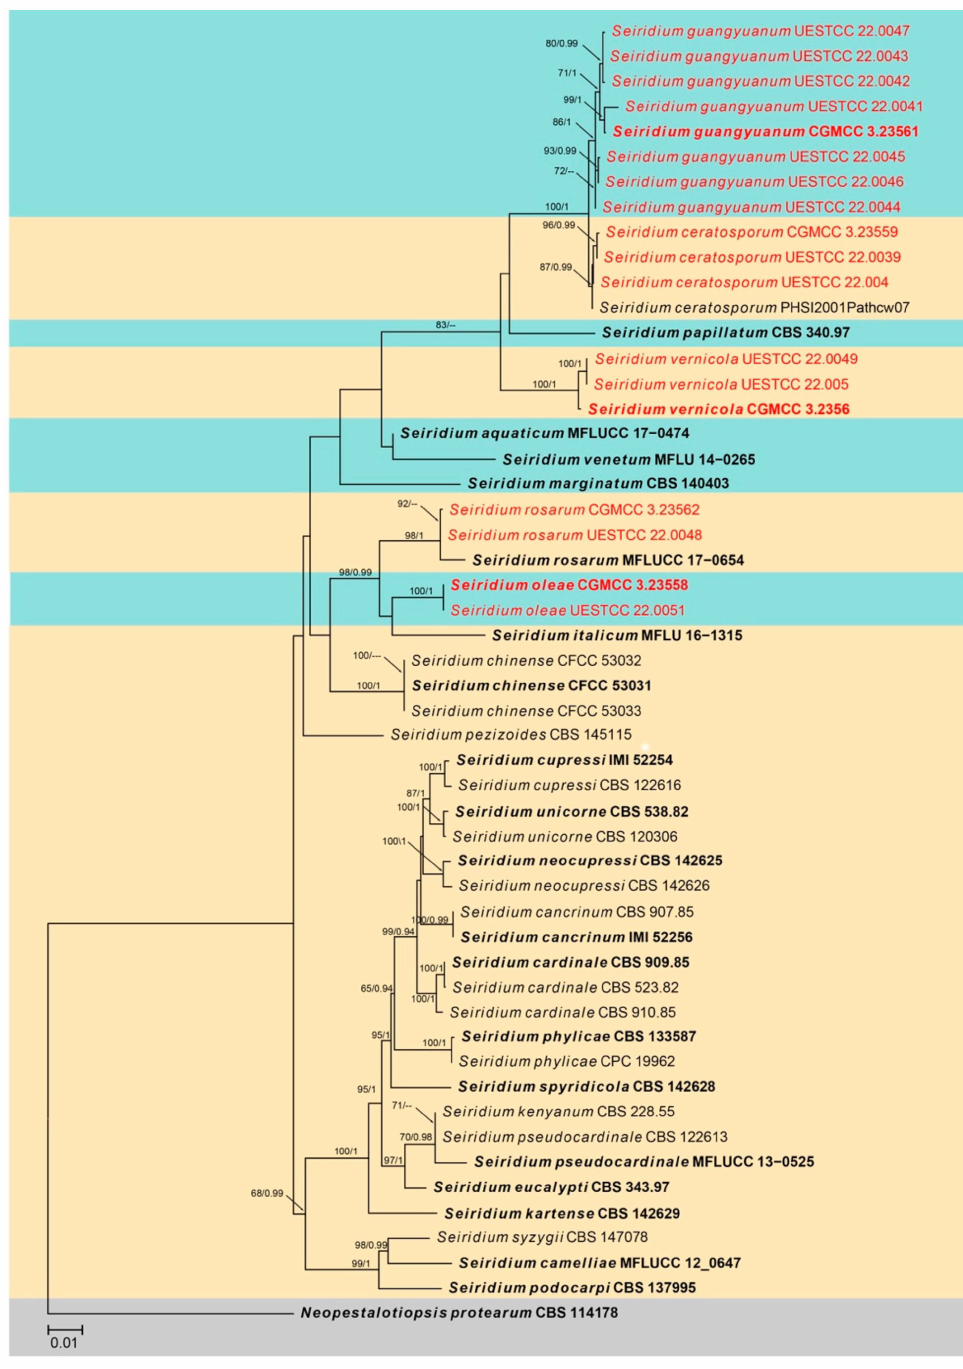
Figure 4. Phylogram generated from RAxML analysis based on combined LSU, ITS, tub2 , tef1- α and rpb2 sequence data of Seiridium isolates. The tree was rooted to Neopestalotiopsis protearum (CBS 114178). The ML, MP bootstrap supports ( ≥ 60%) and BI posterior probabilities ( ≥ 0.90 PP) supports are given near the nodes, respectively. Isolates from this study are marked in red and ex-type strains are marked in